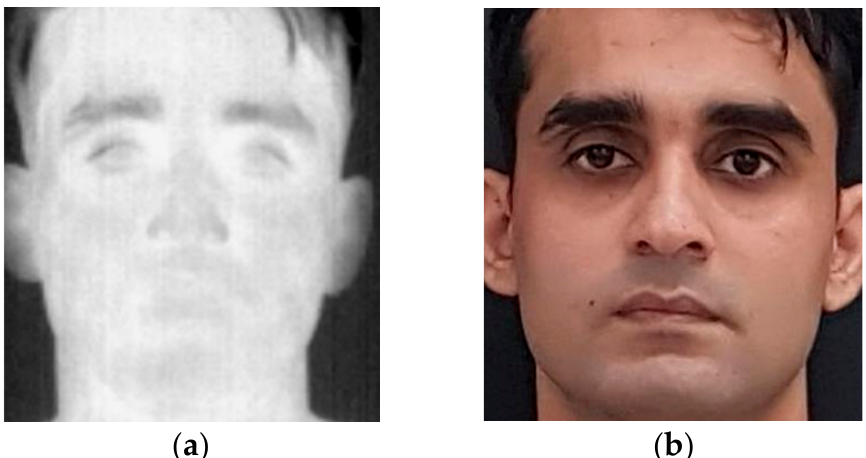
Figure 4. Sample face images from Sejong Face dataset: ( a ) thermal infrared; ( b ) visible spectrum.